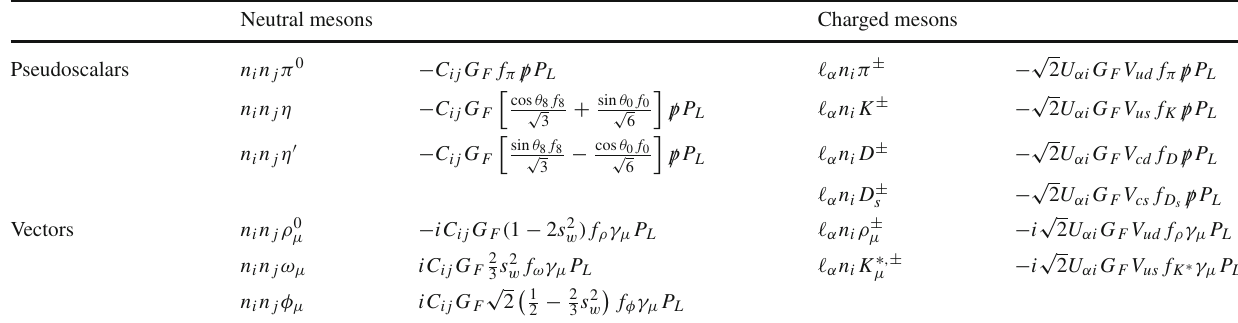
Table 5 List of Feynman rules for the effective vertices involving neu- trinos and mesons, where p is the 4-momentum of the corresponding pseudoscalar meson. Here, latin (greek) indices refer to the mass (fla- vor) basis. The Feynman rule for the vertex involving two pseudoscalar mesons, a neutrino and a charged lepton can be derived from Eq. (65).